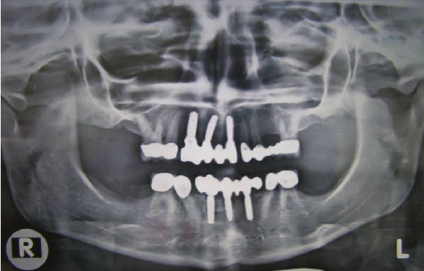
Figure 9: Radiograph taken after 6 months of cementation of the